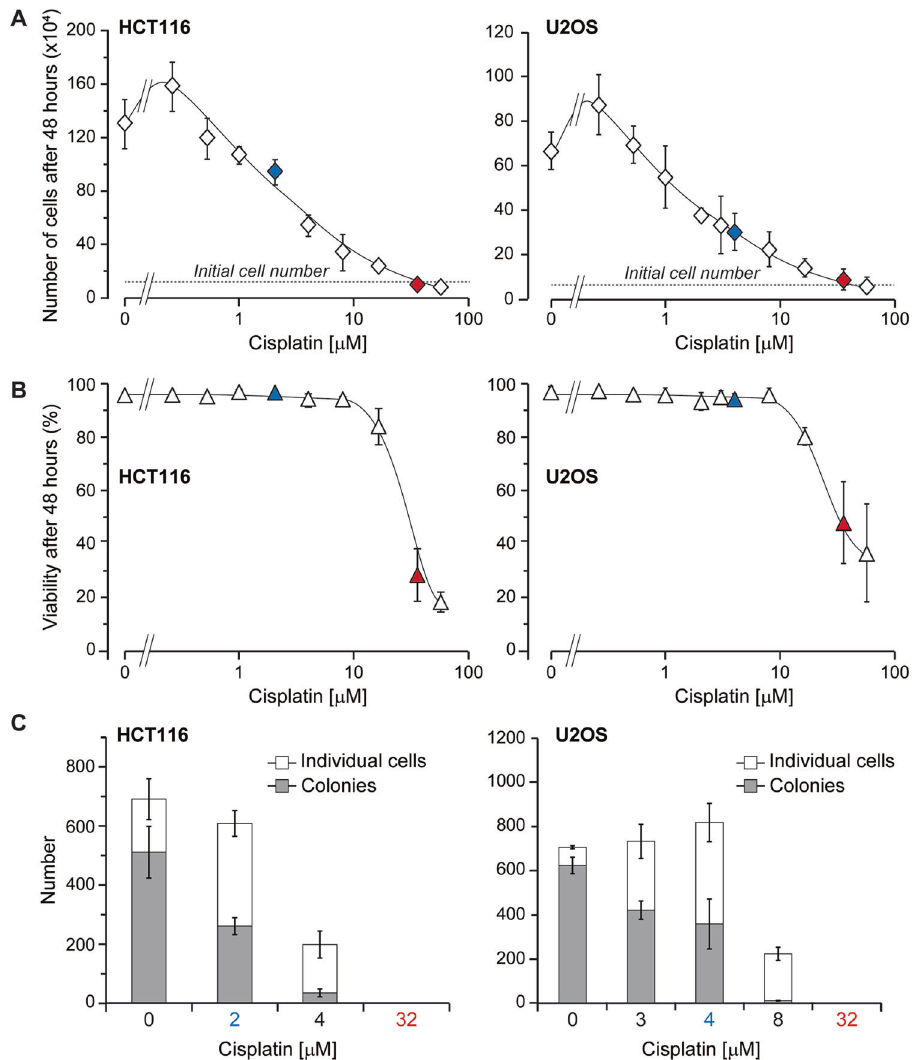
Fig. 2 Viability and proliferative capacity of cells exposed to increasing cisplatin concentrations. HCT116 and U2OS WT cells (120,000 cells seeded in wells of 6-well plates) were treated for 48 h with the indicated cisplatin concentrations. A – B Viability (panel A ) and cell number (panel B ) were determined through trypan blue staining. The results correspond to the mean ± 95% con fi dence interval (CI) of three independent experiments. C Following the 48 h incubation with the indicated cisplatin concentrations, cells were trypsinized and fi ve hundred of them were plated in 10-cm Petri dishes and grown for 10 days in culture medium without cisplatin. The number of colonies (cluster of 2 or more cells) and isolated cells (single cell “ colonies ” ) in the plates was then recorded. Results correspond to the mean ± 95% CI of two independent experiments. Conditions highlighted in blue and red correspond to cisplatin concentrations that activate low CASP3-like activity in live cells and high CASP3-like activity in apoptotic cells, respectively (see Fig. 1). occurring on low abundance proteins are often inaccurate due to Formation of a ladder of protein species above the full-length the poor identi fi cation of scarce proteins by mass spectrometry protein is indicative of ubiquitination. This can be accompanied [64]. In this context, we note that the proteins found here to be (middle example in Fig. 3B) or not by the presence of a ladder of post-translationally modi fi ed are generally rather abundant fragments below the full-length protein, the latter case corre- proteins (Supplementary Figure S5). This is also due to the fact sponding to global, proteasome-mediated, degradation. The that PTMs happens at a sub-stoichiometric level [65]. appearance of discrete specie(s) above the full-length protein is A total of 1006 proteins were found to have their gel migration indicative of covalent linkage of structures to the protein following pattern modi fi ed upon apoptosis induction (Table 1 and Excel S1). events such as phosphorylation, acylation, glycosylation, etc. This Most of these changes were consistent with proteolysis (Table 1). type of pattern is coined “ tagging ” here. When it was not possible Upon induction of non-lethal stress, 397 proteins with distinct to assign a PTM to one of the examples shown in Fig. 3B, the PTM migration pattern were detected (Table 1 and Excel S2). Interest- was classi fi ed as “ other ” . Unde fi ned PTMs may originate from the ingly, discrete cleavage of proteins was not the predominant type combination of several PTMs, from the addition of structures such of PTMs detected upon mild stress induction as the different types as palmitoyl groups that hamper peptide identi fi cation by mass of pattern consistent with different PTMs occurred with relatively spectrometry [43], or even from the stress-related appearance of similar frequencies in this condition (Table 1). We also detected that splice variants presenting different gel migration patterns. PTMs